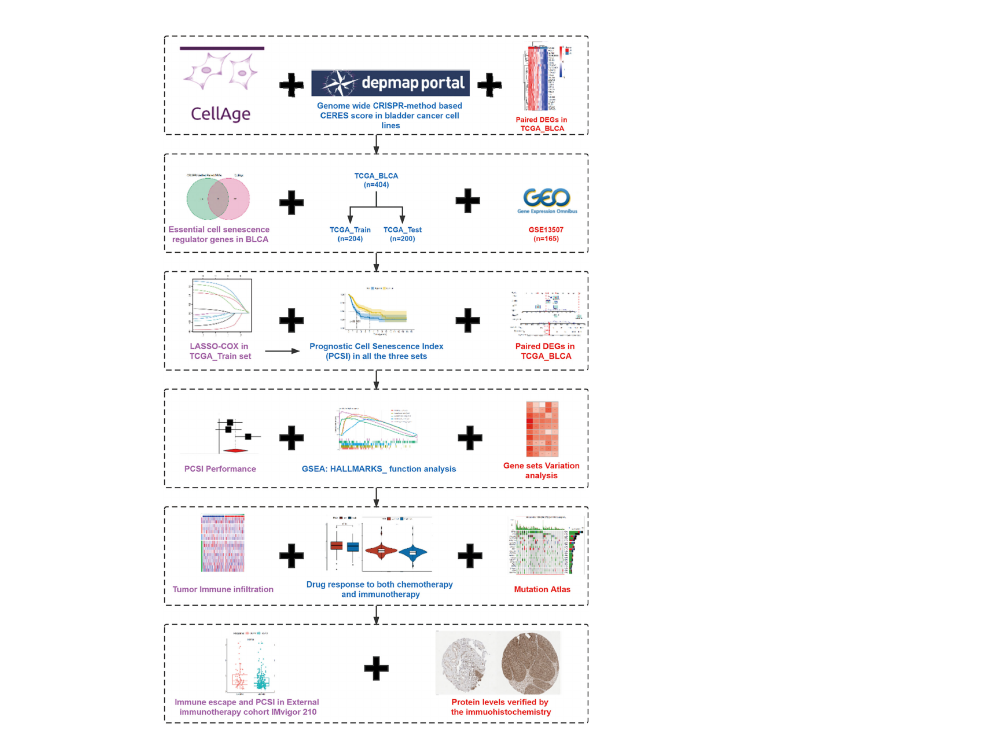
FIGURE 1 | The fl owchart and graphic abstract of this